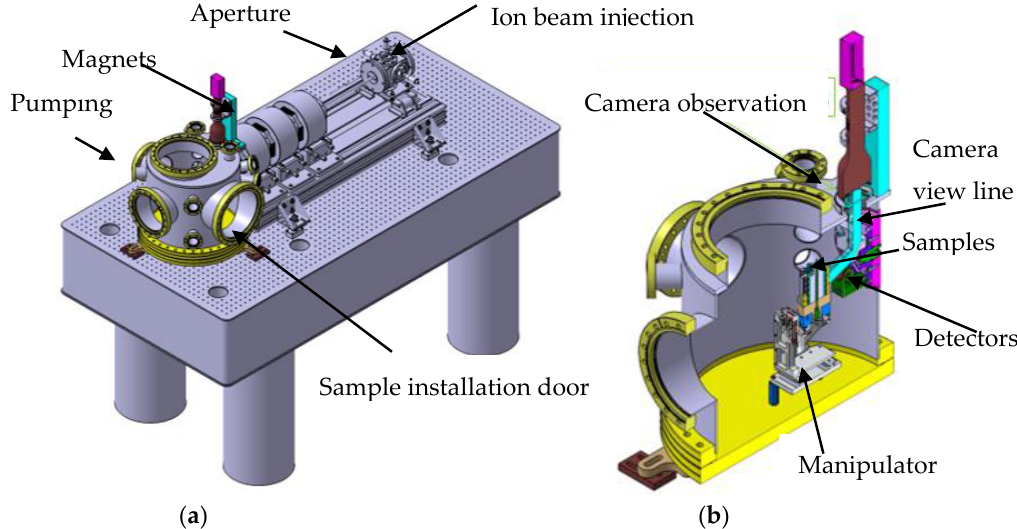
Figure 2. CAD drawings of the µNRA setup (dotted square in Figure 1). ( a ) The µNRA vacuum chamber (flanges in yellow) together with the three focusing magnets and an aperture on a vibration-damping table. ( b ) Detailed crosscut of the vacuum chamber with sample manipulator, observation, charged particle detectors, and holder.